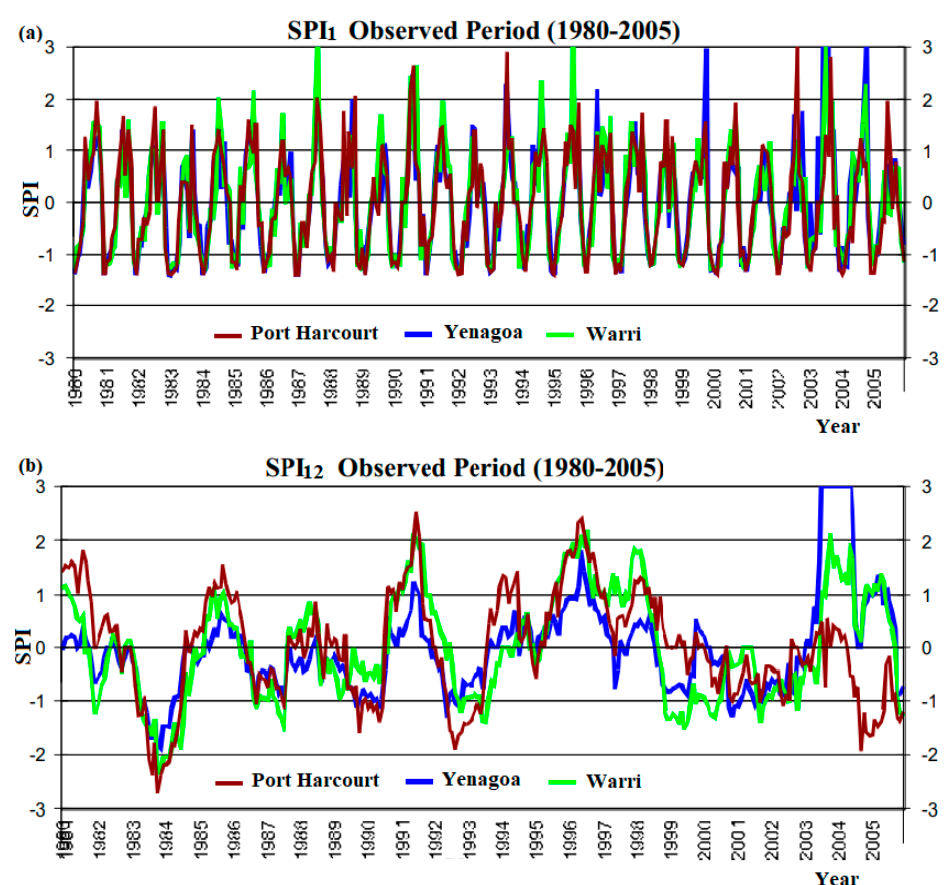
Figure4. Figure 4. Computed standardized precipitation index (SPI) for the base period across the study locations.